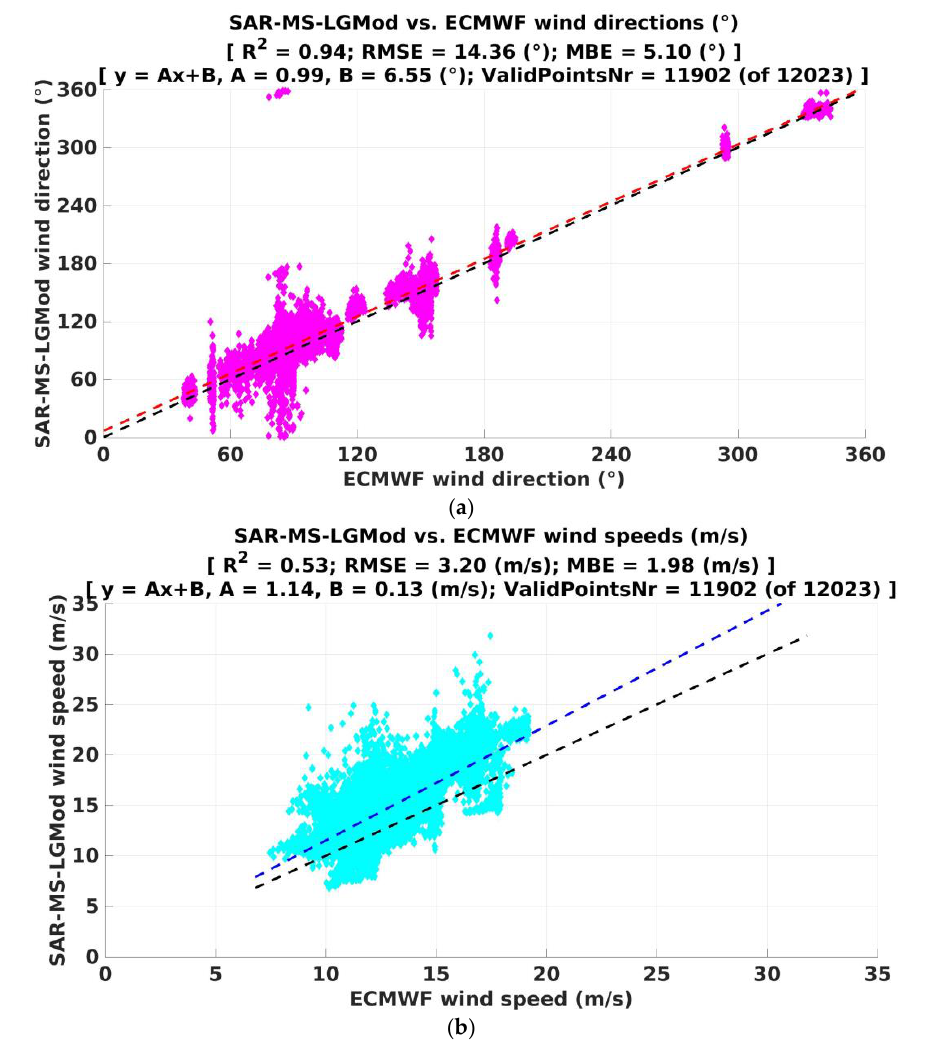
Figure 8. ( a ) Scatterplot of the MS LG-Mod SSW direction ( y axis) and the European Centre for Medium-Range Weather Forecasts (ECMWF) model direction ( x axis), for all the 5 km by 5 km ROIs (N_ROI = 11,902). Red dashed line shows the regression line with a slope A = 0.99. ( b ) Scatterplot of the SAR SSW speed ( y axis) and the ECMWF model speed ( x axis), for the same ROIs and the CMOD5.N. Cyan dashed line shows the regression line with a slope A = 1.14. Both black dashed lines represent the reference line with a slope of